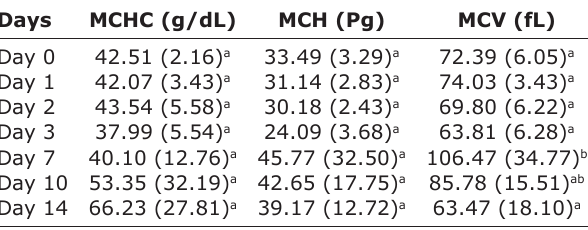
Table 5: Changes in the mean corpuscular values of CPDA-1 SCB PS. Days MCHC